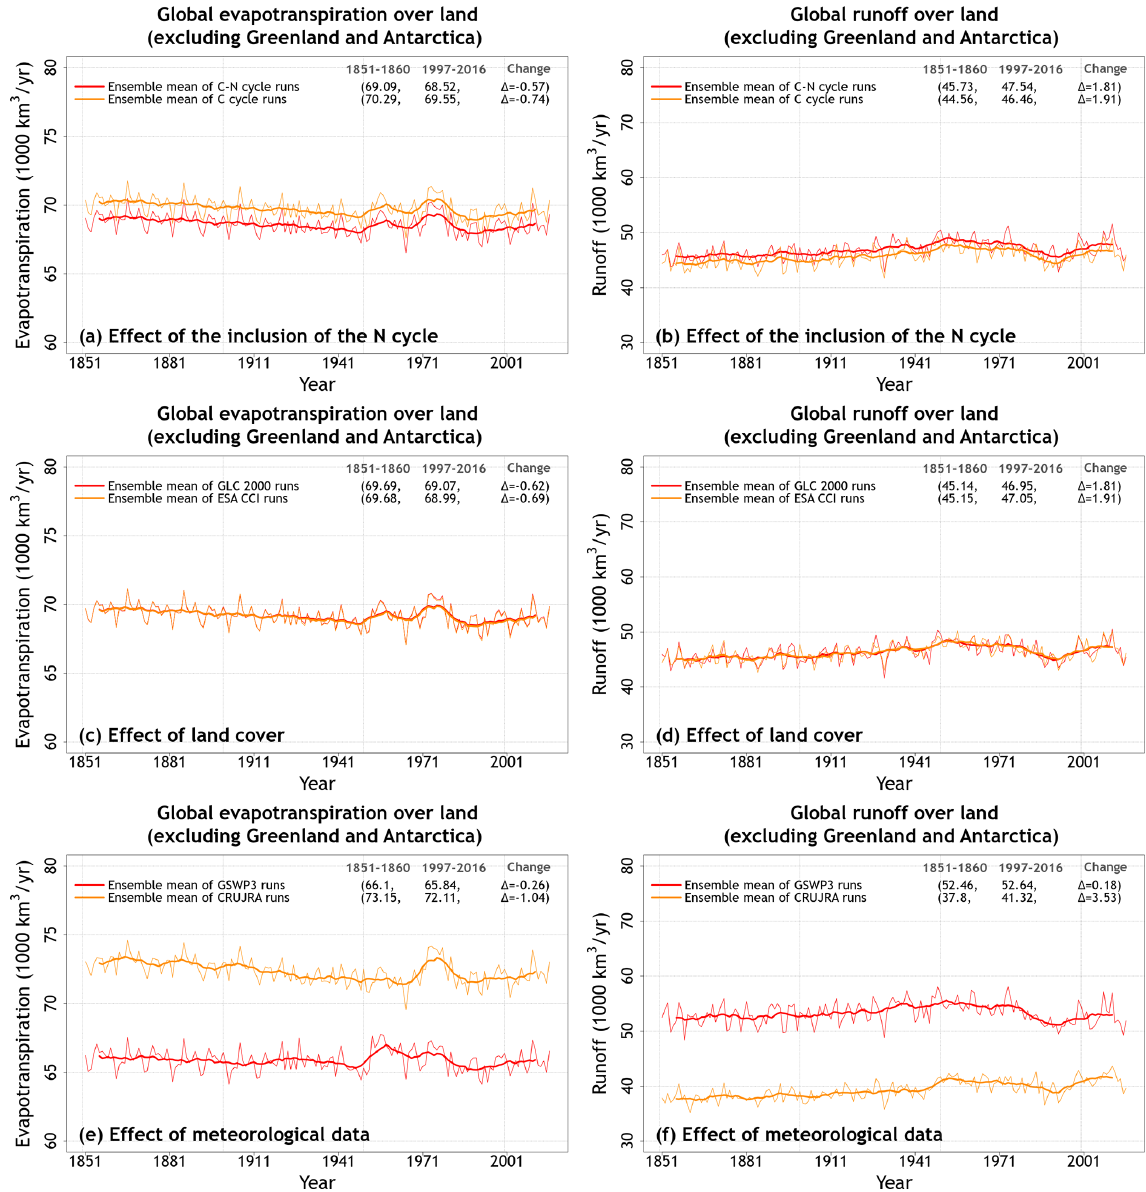
Figure 3. Time series of annual global evapotranspiration and runoff (over all land area excluding Greenland and Antarctica) averaged over the four ensemble members that are driven with and without an interactive N cycle (a, b) , that are driven with the GLC-2000- and ESA-CCI- based land cover (c, d) , and that are driven with the GSWP3 and CRU-JRA meteorological data (e, f) . The thin lines show the individual years, and the thick lines show their 11-year moving average. Model values averaged over the pre-industrial (1851–1860) and present-day (1997–2016) time periods, and their difference, for each ensemble averaged over its set of four simulations are also